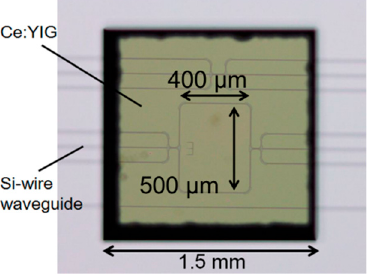
Figure 2. Microscopic image of fabricated MZI isolator on a silicon-on-insulator (SOI) platform. A 1.5-mm square die of cerium-substituted-YIG (Ce:YIG)/substituted-GGG is directly bonded on the Si waveguide. Two MZI arms are separated 500-µm away to apply external magnetic field in anti-parallel directions with a permanent magnet.